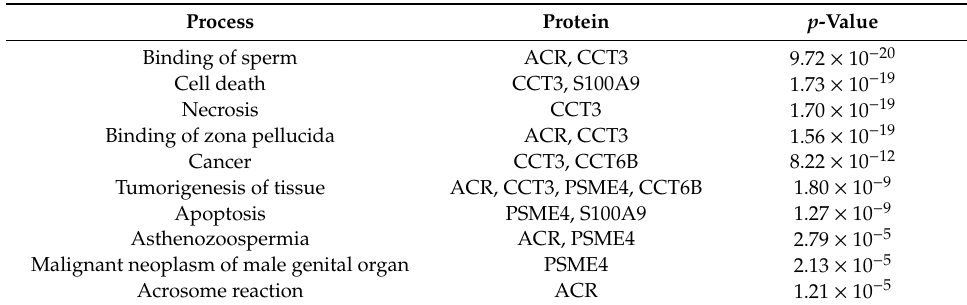
Table 2. Specific diseases and bio functions of the differentially expressed proteins (DEPs) selected for validation by western blotting.